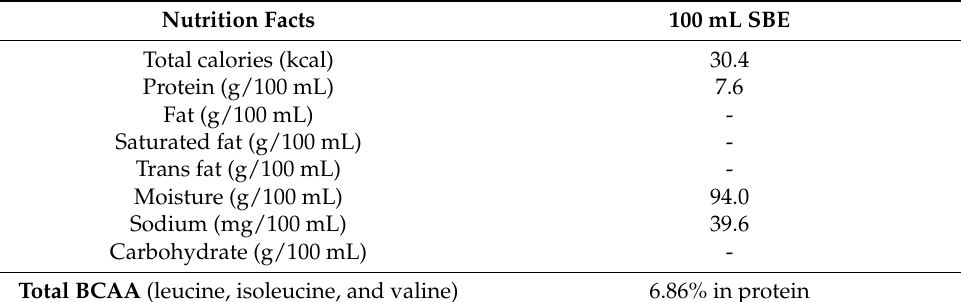
Table 4. Nutritional content of the SBE